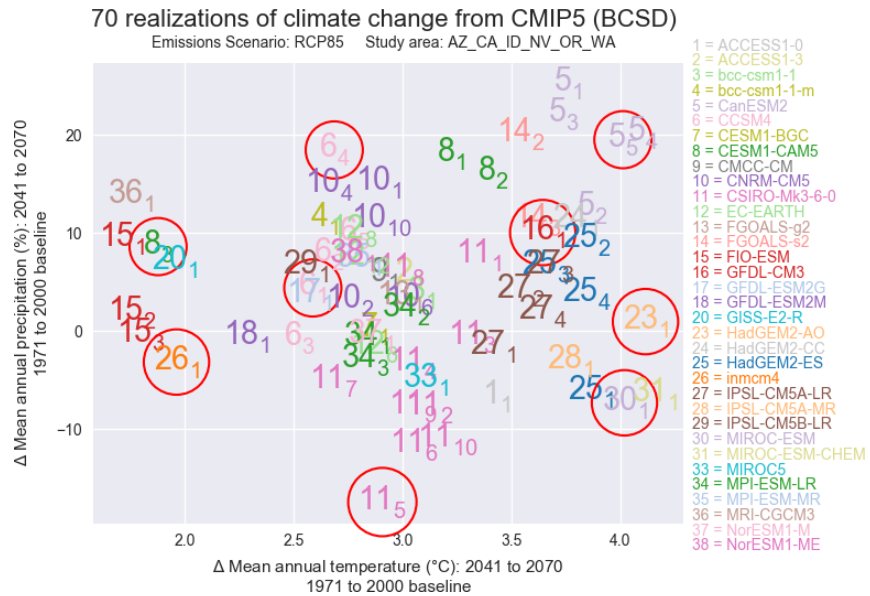
Figure 3. Scatterplot showing the range of mean temperature and precipitation projections for the 2041–2070 climate models across the study area. The circled data points identify the climate projections used in our analyses. Climate models are enumerated using the key to the right of the scatterplot. Subscripts denote the realization number of each unique projection. Legend colors are used to improve legibility where scatterplot symbols